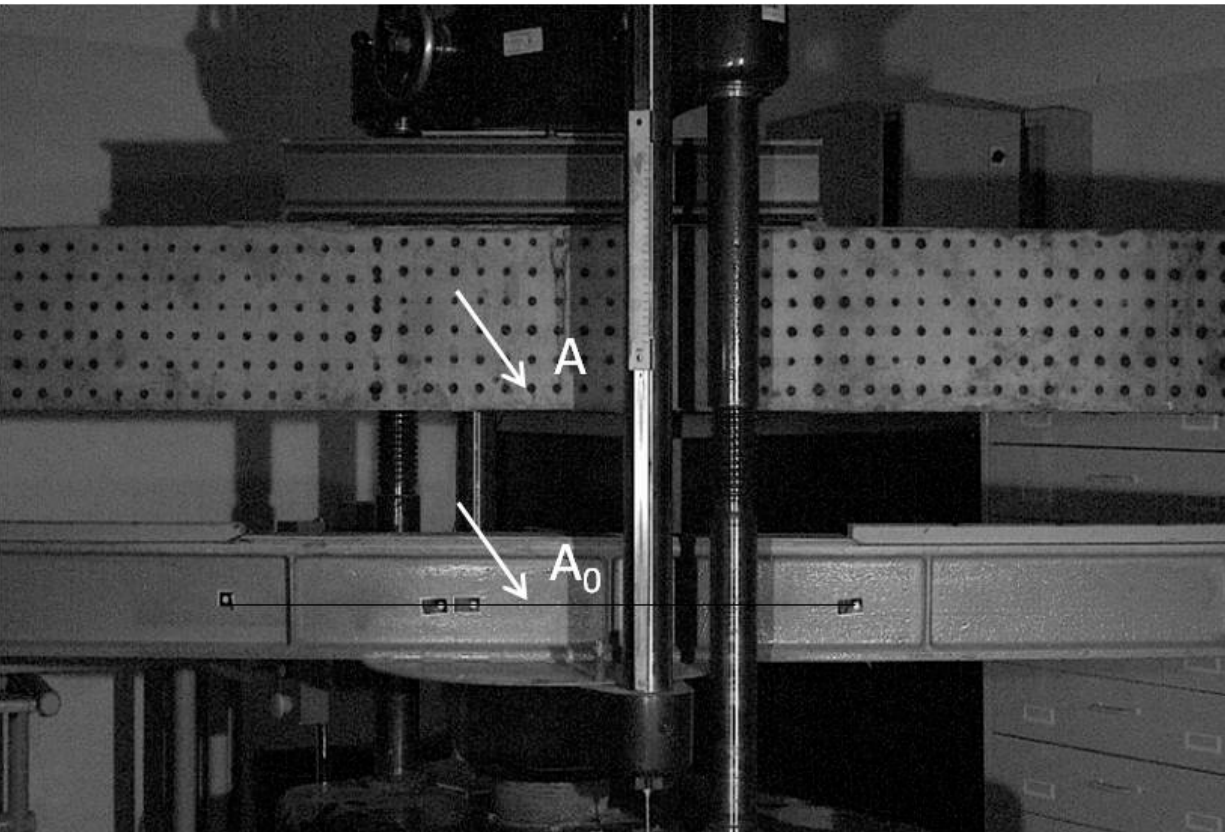
Figure 4. Measurement points for displacements A in relation to the reference point A 0 .